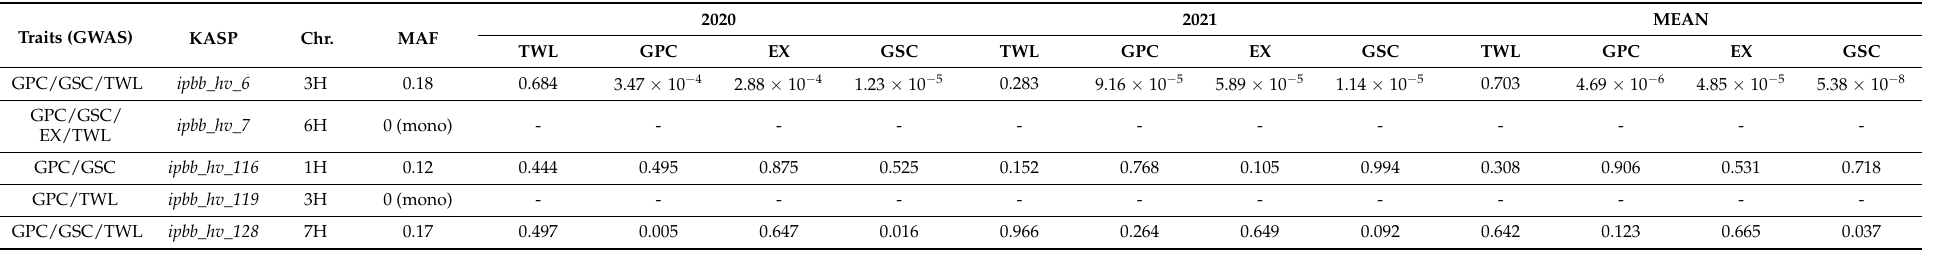
Table 4. The significance of SNP markers associated with grain quality traits using the collection of 34 promising breeding lines. p -values obtained in the t -test are